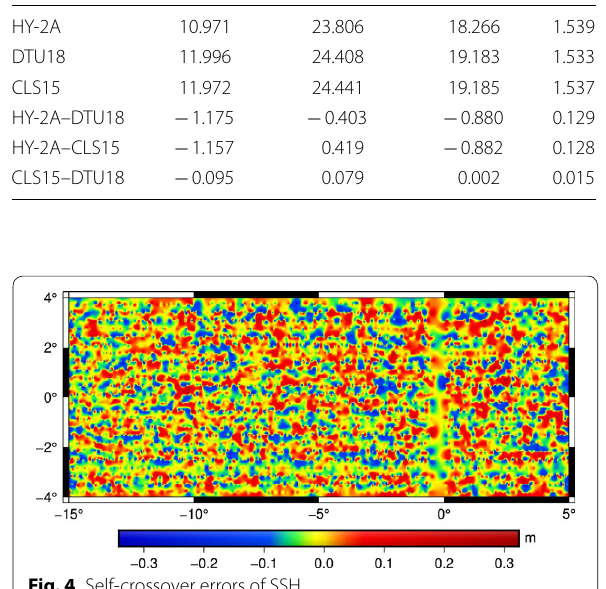
Fig. 3 SSH derived from HY-2A: a 2D view; b 3D view